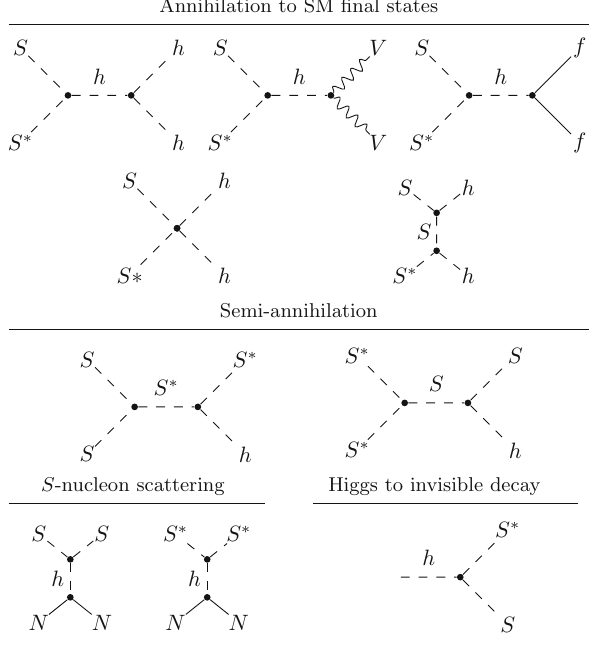
Fig. 1 The diagrams for annihilation, semi-annihilation, scalar- nucleon scattering and Higgs invisible decays in the Z 3 scalar singlet model. Here N denotes nucleons, f are SM fermions and V SM gauge bosons. Except for the semi-annihilation processes, the equivalent dia- grams apply in the Z 2 scenario but with S ∗ replaced with S